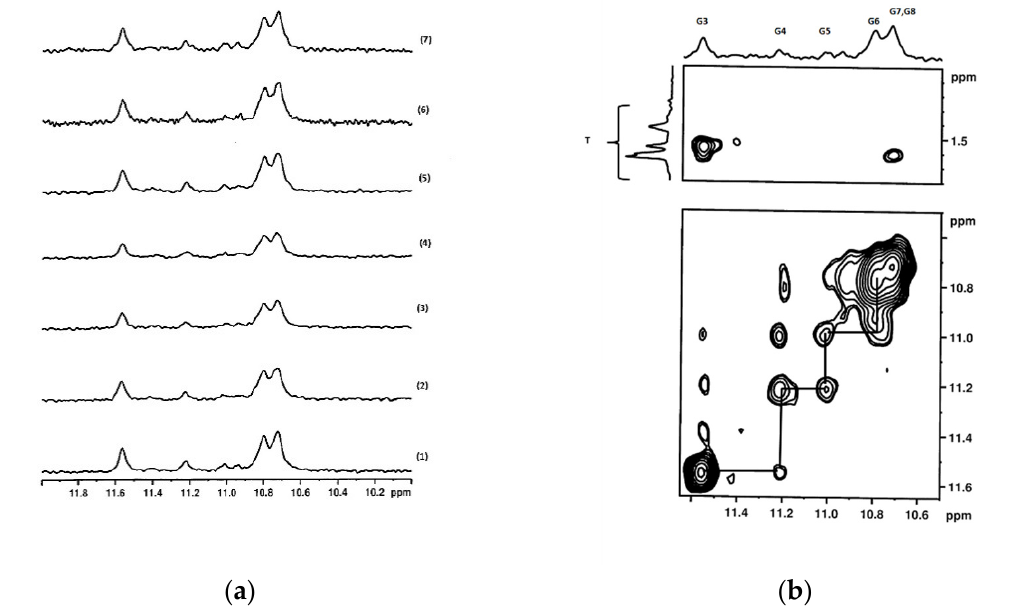
Figure 2. ( a ) Imino proton NMR spectra of oligonucleotide H2 (G − PO − HCV − L235). (1) Sample before heating. (2) Sample after heating at 90 °C for 1 min and move the sample to the magnet for NMR acquisition (approx. at 50 °C) (3) after 13 min, (4) after 30 min, (5) after 50 min, (6) after 65 min, and (7) after 5 months. ( b ) Imino and methyl protons region of 2D-NOESY spectrum of H2 (G − PO − HCV − L235) at 25 °C in H 2 O/D 2 O (9:1), PBS buffer (pH 7.4).